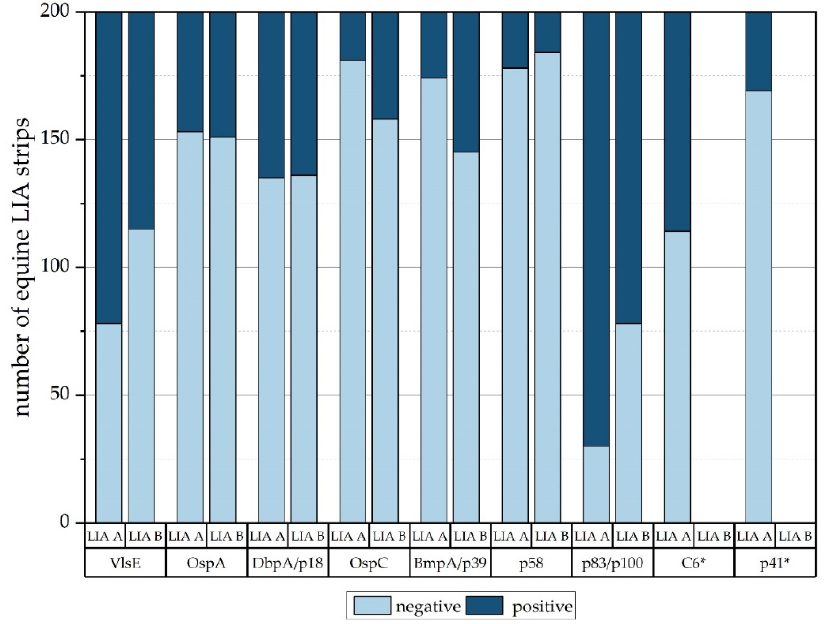
Figure 3. Number of equine AG lines that displayed positive (equal or higher than COC) or negative color reactions on the LIA strips of both LIAs. Antigens marked with * are unique for the respective LIA. When all color reactions on the AG lines (i.e., degree of color reaction (Figures 1 and 2)